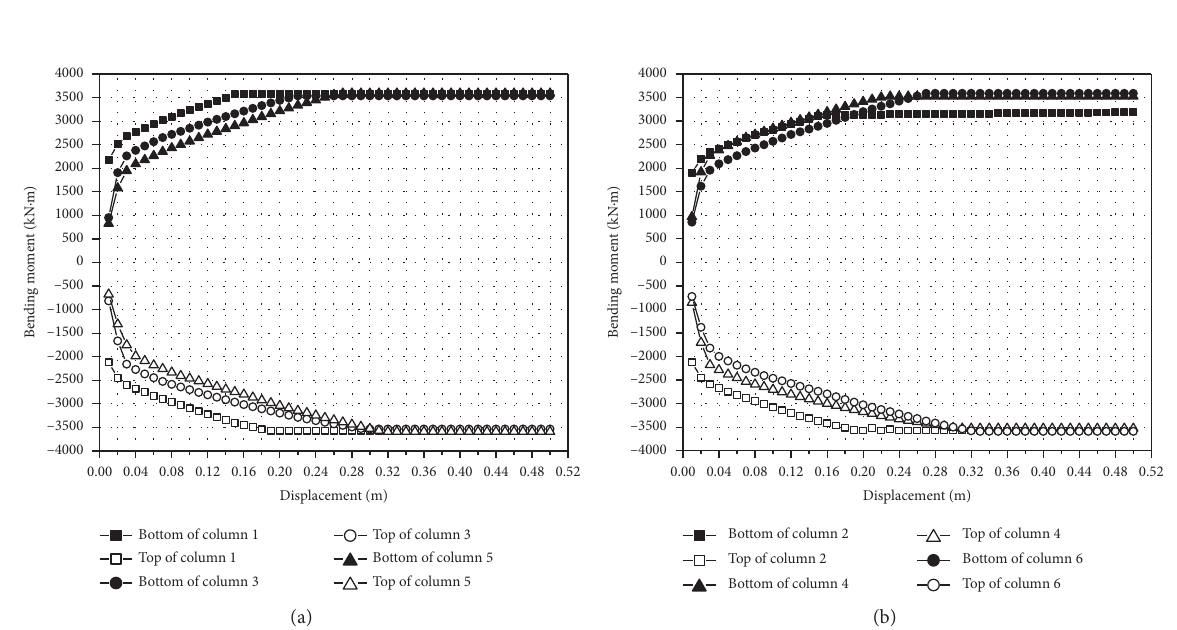
Figure 32: Moment-displacement at the top and bottom of the piers. (a) Moment-displacement at the top and bottom of the piers at the upstream side. (b) Moment-displacement at the top and the bottom of the piers at the downstream side.